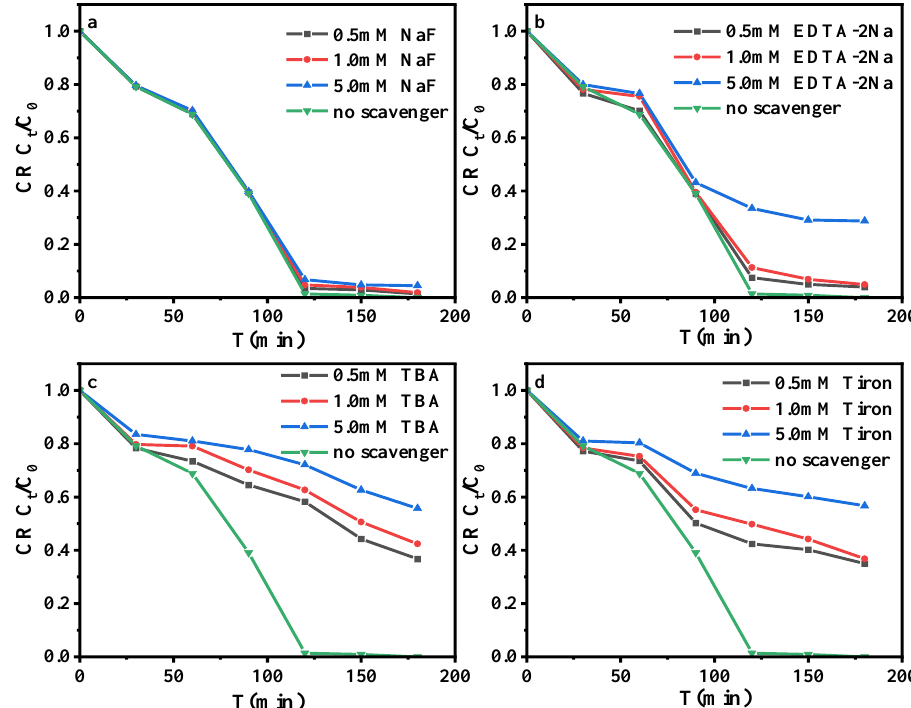
Figure 5. Effect of ( a ) NaF; ( b ) EDTA-2Na; ( c ) TBA; and ( d ) Tiron quenching agent on CR removal efficiency. Reaction conditions: light intensity = 80 W; [CR] = 100 mg/L; and pH = 8.2; [CaWO 4 ] = 1.0 g/L.